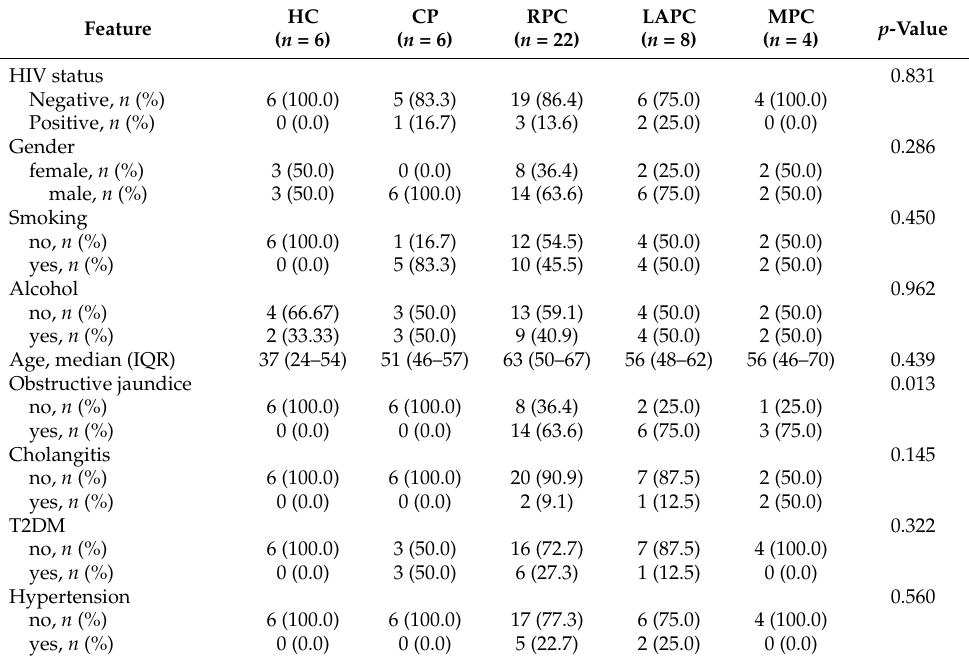
Table 1. Demographic features and clinicopathological of Chronic Pancreatitis and Pancreatic Ductal Adenocarcinoma patients.